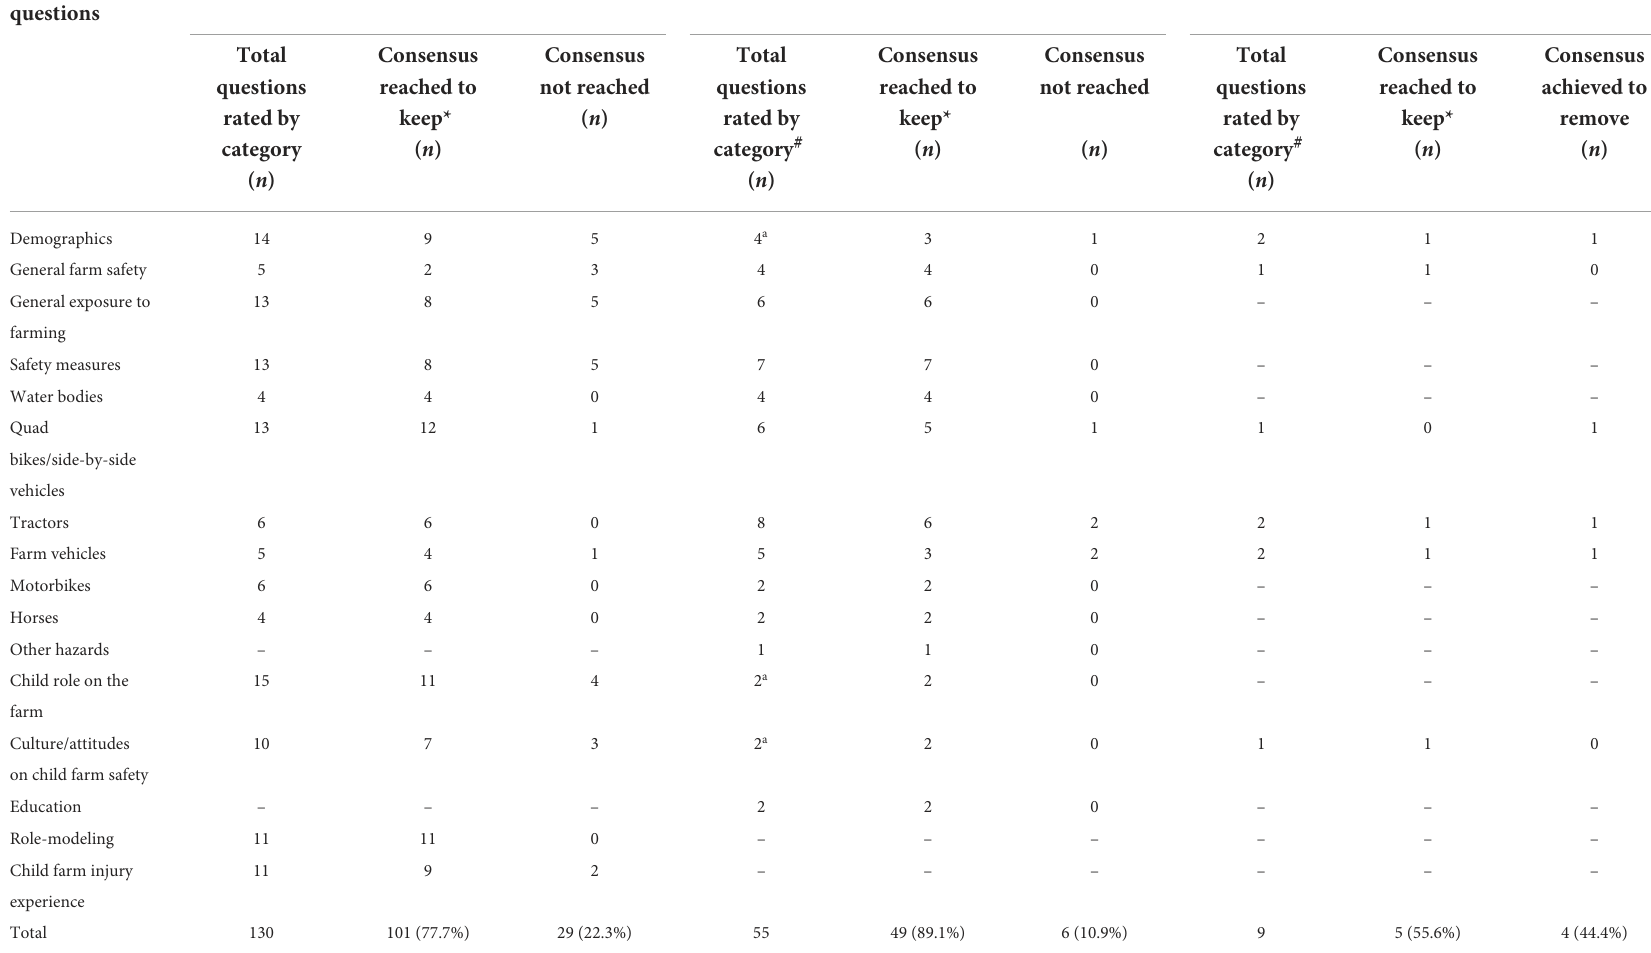
TABLE 2 Results of the Delphi method consensus process for the parent survey by round and question